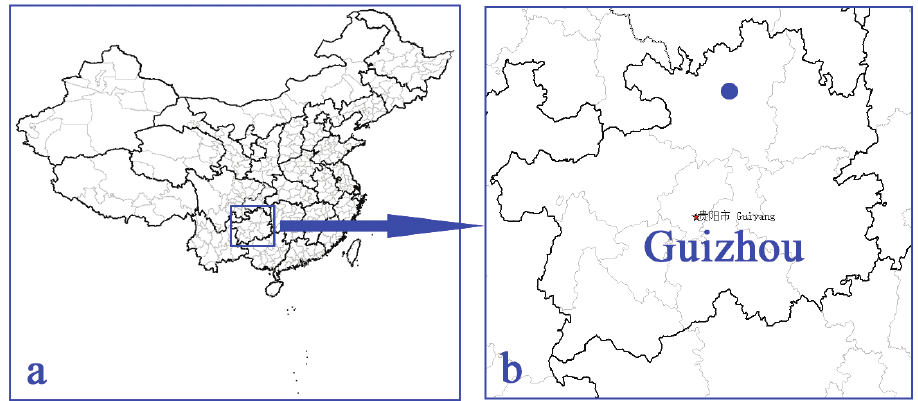
Figure 1. Distribution of Shuangheaphaenops elegans gen. n., sp. n. a map of China showing the location of Guizhou Province b map of Guizhou Province, the location of Shuanghe Dong cave system shown by blue